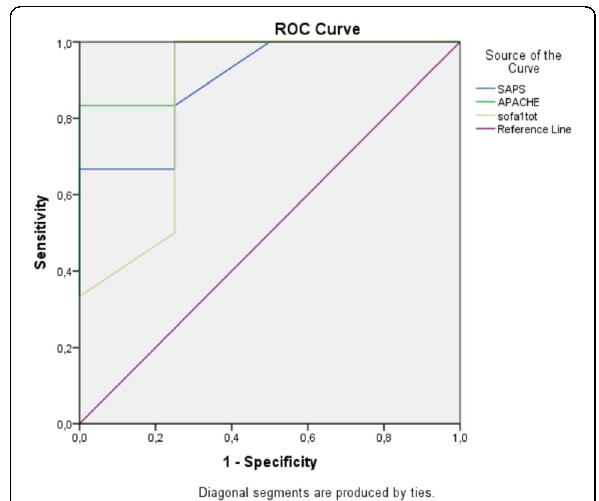
Fig. 1 (abstract 001592). Correlation between MR-proADM in patient with level > 1.5nmol/I and SAPS II, APACHE II and SOFA score at the ICU admission (T1). AUC SAPS II, 0.90[CI 0,69-1] p=0.04, AUC APAcHE II, 0.96 [CI 0.84-1] p=0.02, AUC SOFA 0.85 [CI 0.56-1] p=